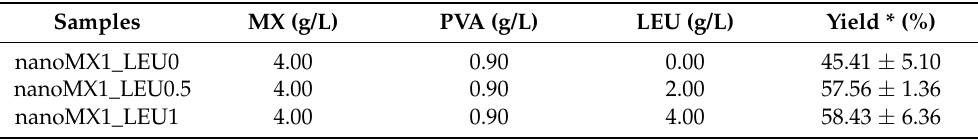
Table 1. Composition of the samples and the yield of spray-drying. MX, meloxicam; PVA, poly-vinyl- alcohol; LEU, L -leucine.